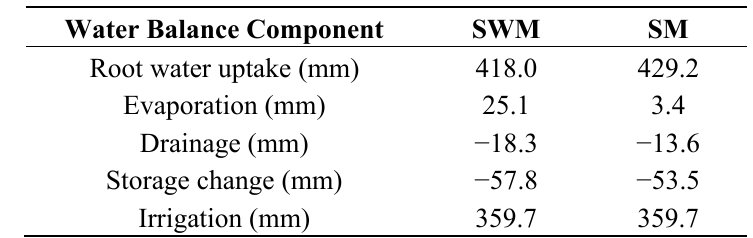
Table 6. Simulated water balance components under the two scenarios, i.e. , SWM (scenario without mulch) and SM (scenario with